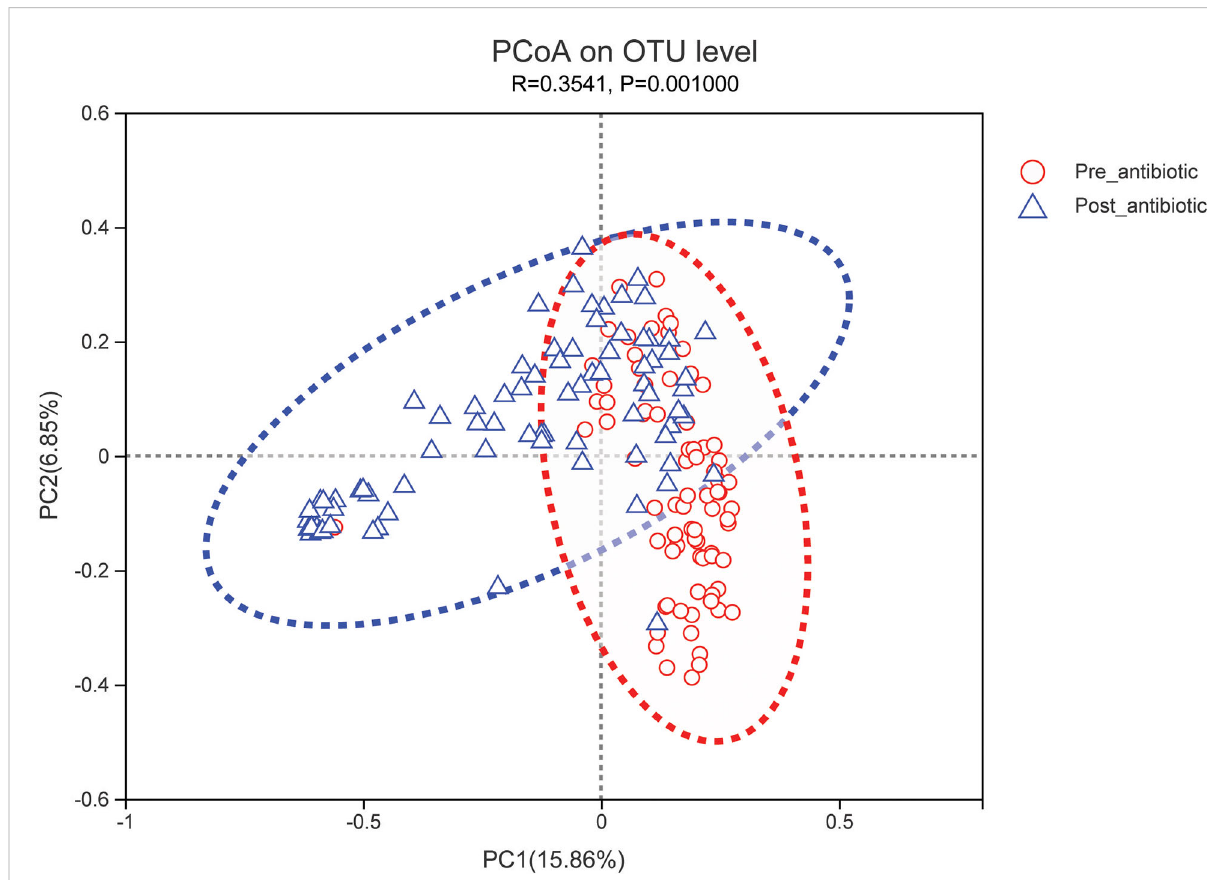
FIGURE 9 PCoA (principal coordinates analysis) of gut microbiota for elderly patients. The dotted line represents the 95% con fi dence interval